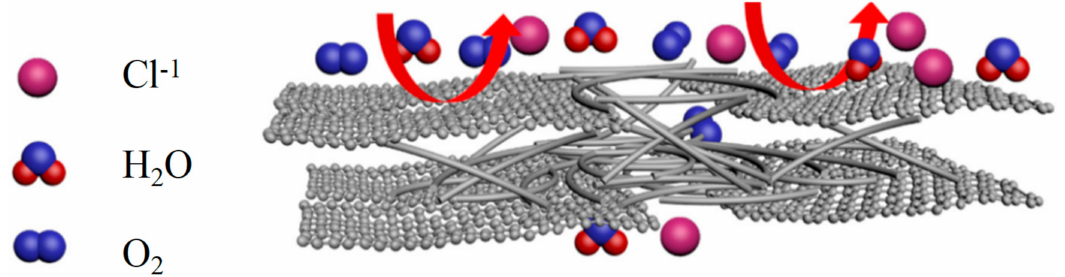
Figure 7. FGO and FMWCNTs in the PU matrix that act as shields within the coating. Reprinted with permission from [40].